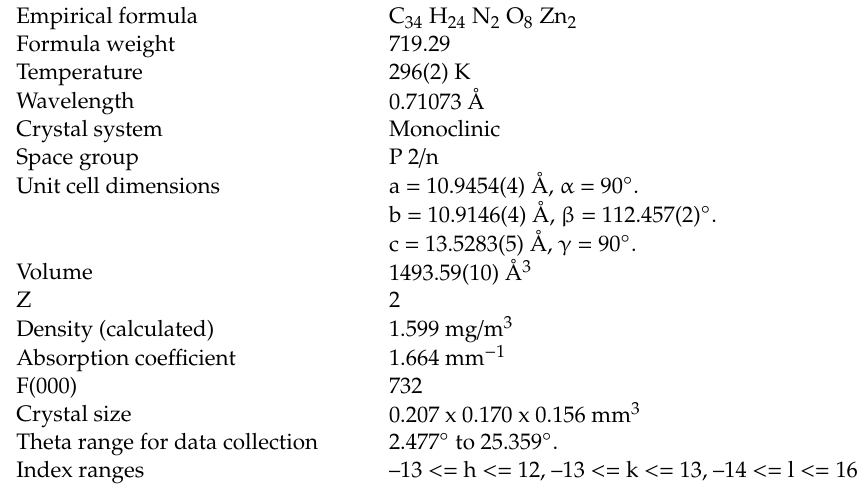
Table 1. Crystal data and structure refinement for 1